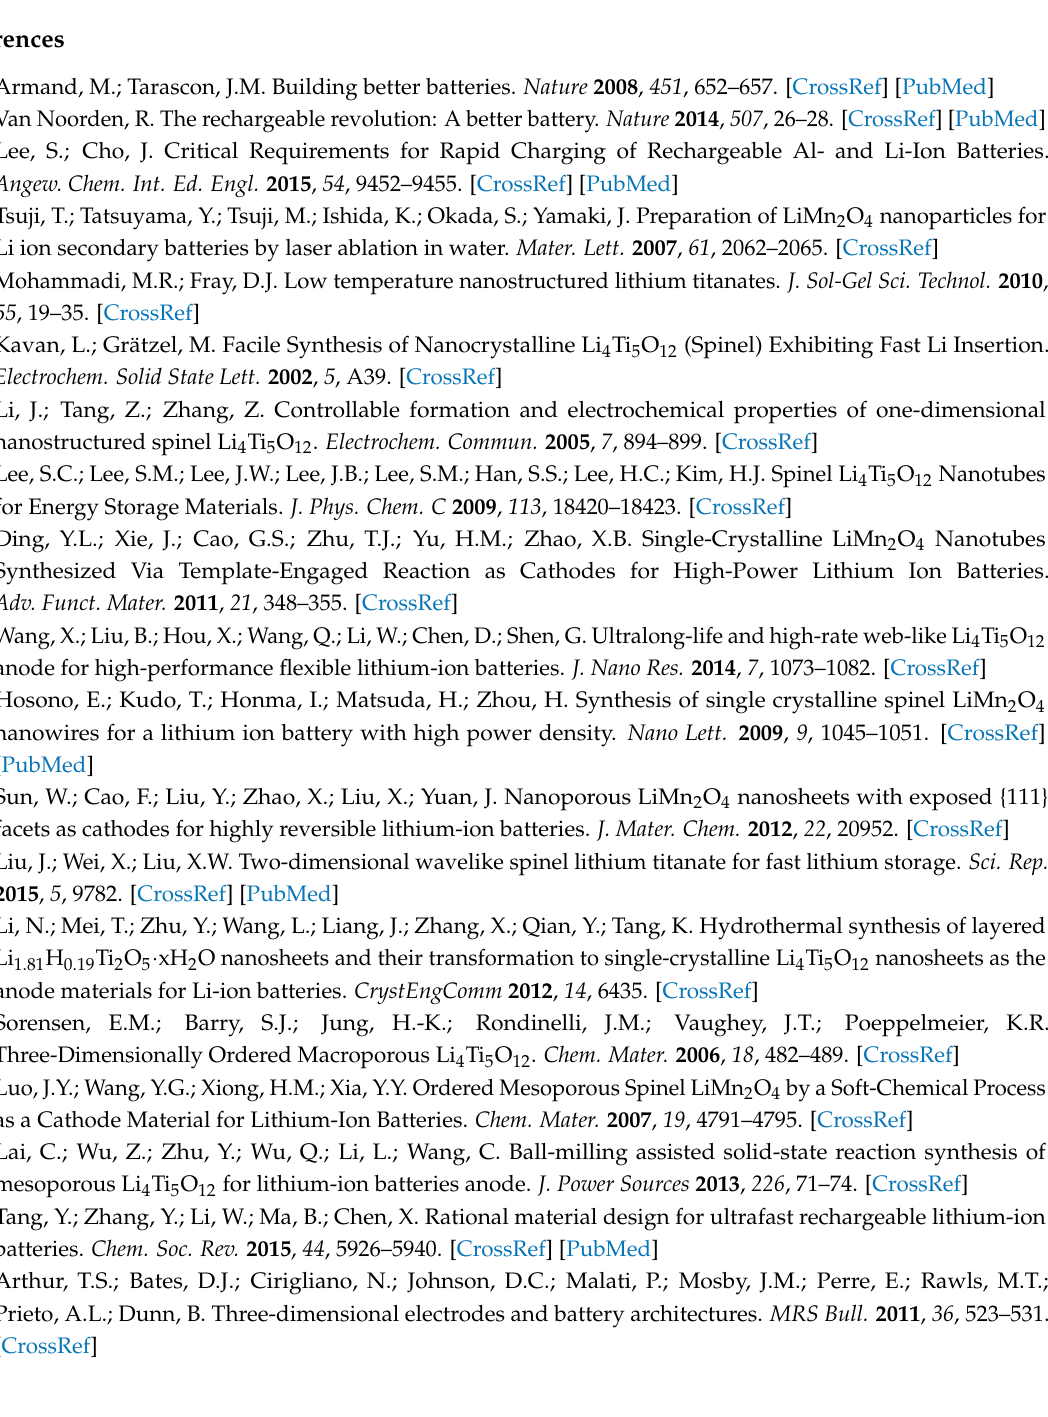
Figure S1: Thermogravimetric analysis in air of LMO-Precursor, VACNT and VACNT coated with LMO-Precursor at a rate of 1 K min − 1 , Figure S2: SEM images of a LMO-VACNT nanoarray transferred onto a primered aluminium substrate in top view (left) and side view (right), Figure S3: 67 wt % LMO-nanoarray synthesized via pretreatment at 350 ◦ C in argon and subsequent annealing at 225 ◦ C / 12 h in air, Figure S4: Long term cycling stability of LTO-VACNT//LMO-VACNT full cells at 10